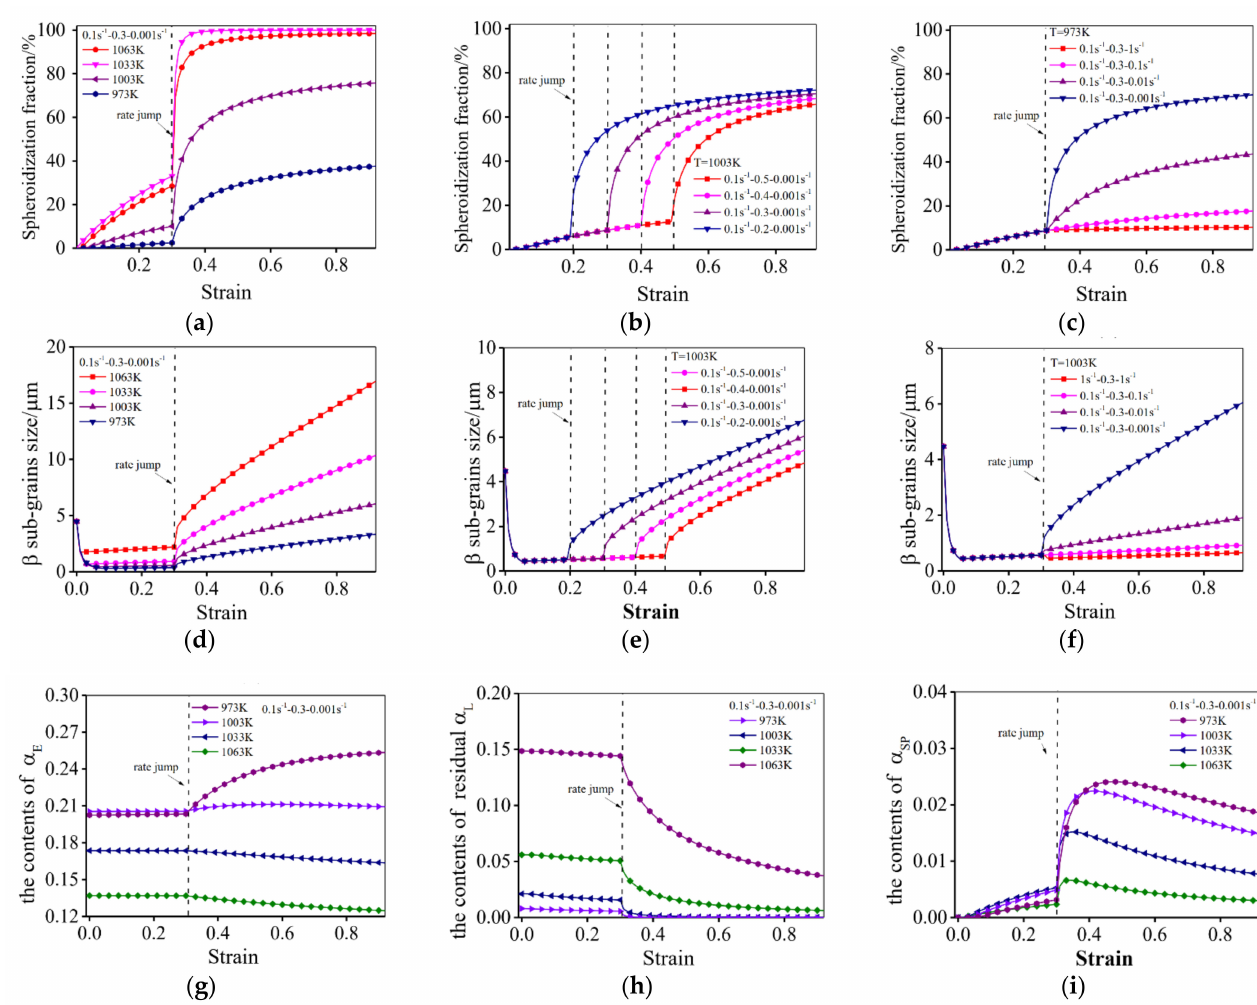
Figure 11. Prediction of microstructure evolution under different testing conditions: ( a – c ) spheroidization fraction of α L ; ( d – f ) β subgrains size; ( g – i ) the contents of α E , α L and α SP